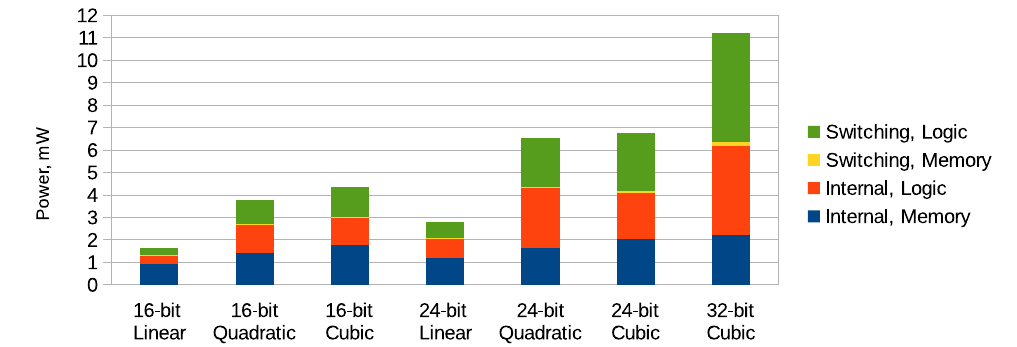
Figure 6. Comparison of memory vs. logic power consumption, f ( x ) = 1/ x